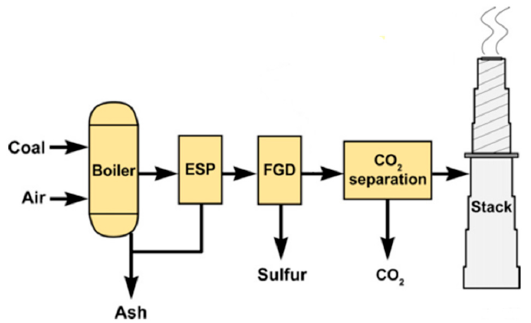
Figure 3. Schematic diagram of a simplified flue gas cleanup process for post combustion carbon capture [32].